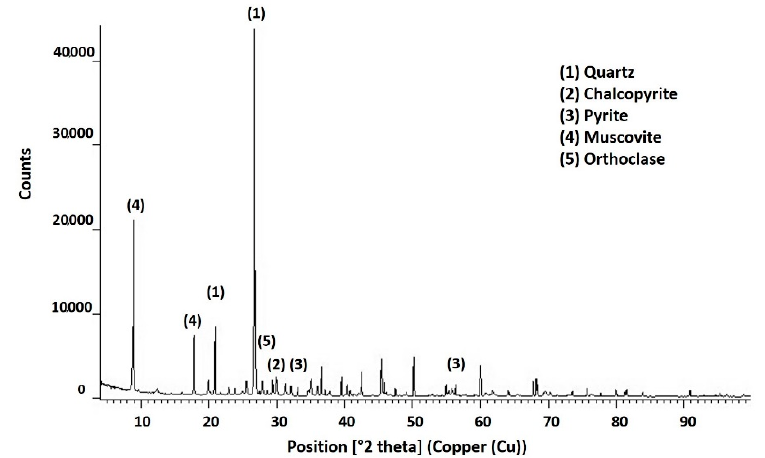
Figure 2. X-ray diffraction pattern of the initial sample. Table 1. Minerals in the copper sulphide ore sample (mass in %) based on Qemscan analysis.